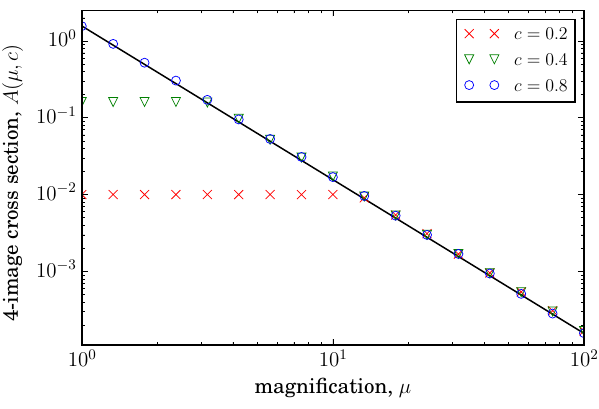
Figure 5. The colored points show the area cross section A ( µ , c ) in the four-image region, computed numerically for different c -slices. The solid line shows A ( µ , c ) = π / ( 2 µ 2 ) , in agreement with the result obtained analytically in Equation (4) (with ˜ µ = µ /2). The cross section curves level off at the magnification that corresponds to the center of the